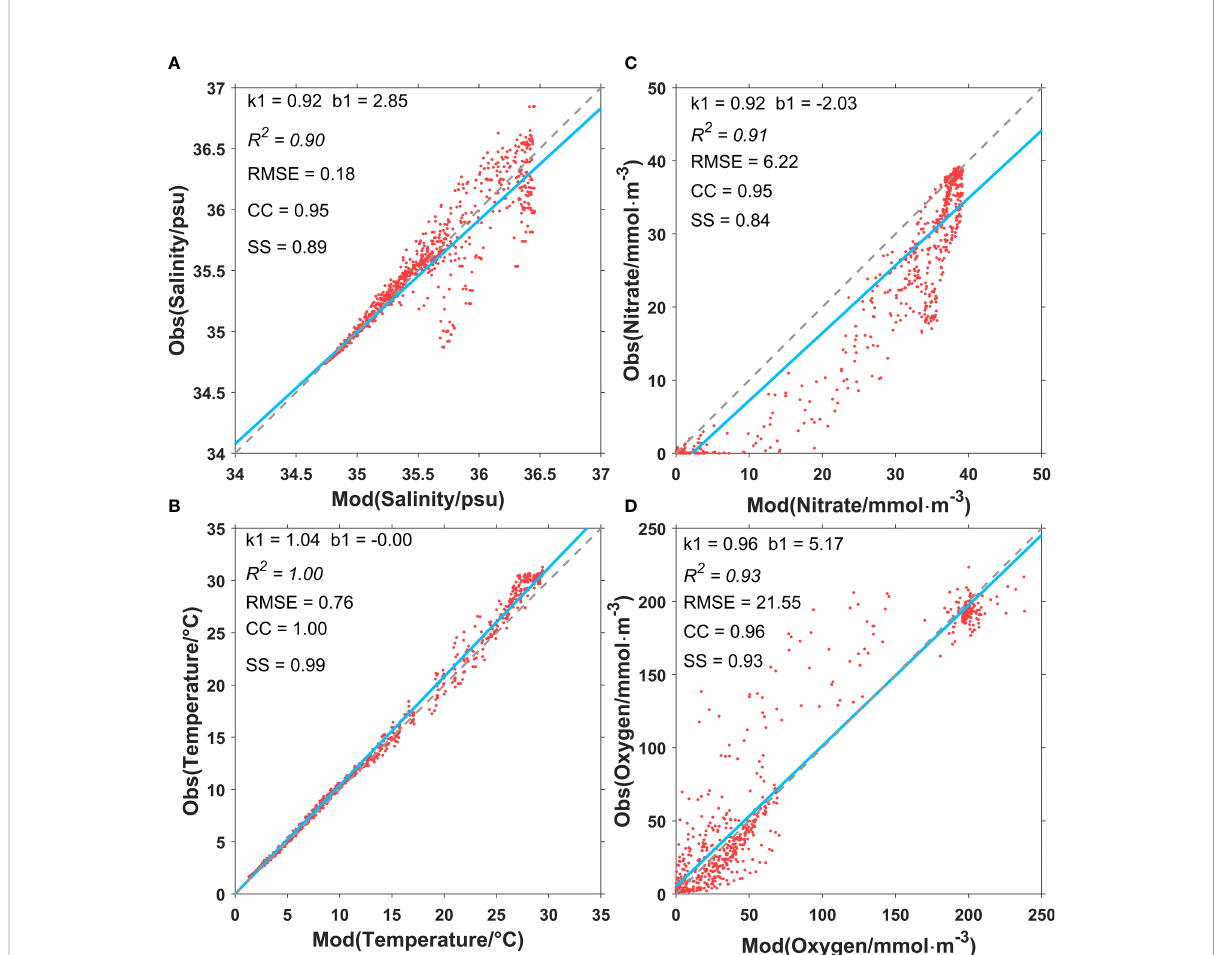
FIGURE 3 Model-data point-to-point comparison for salinity (A) , temperature (B) , nitrate (C) , and dissolved oxygen (D) in the upper 1500 m. The observation data are the I07N cruise data in 2018. RMSE, root-mean-square error; CC, correlation coef fi cient; SS, skill